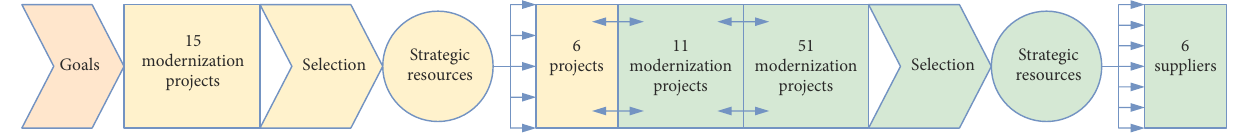
Figure 4. PPM selection process algorithm (created by